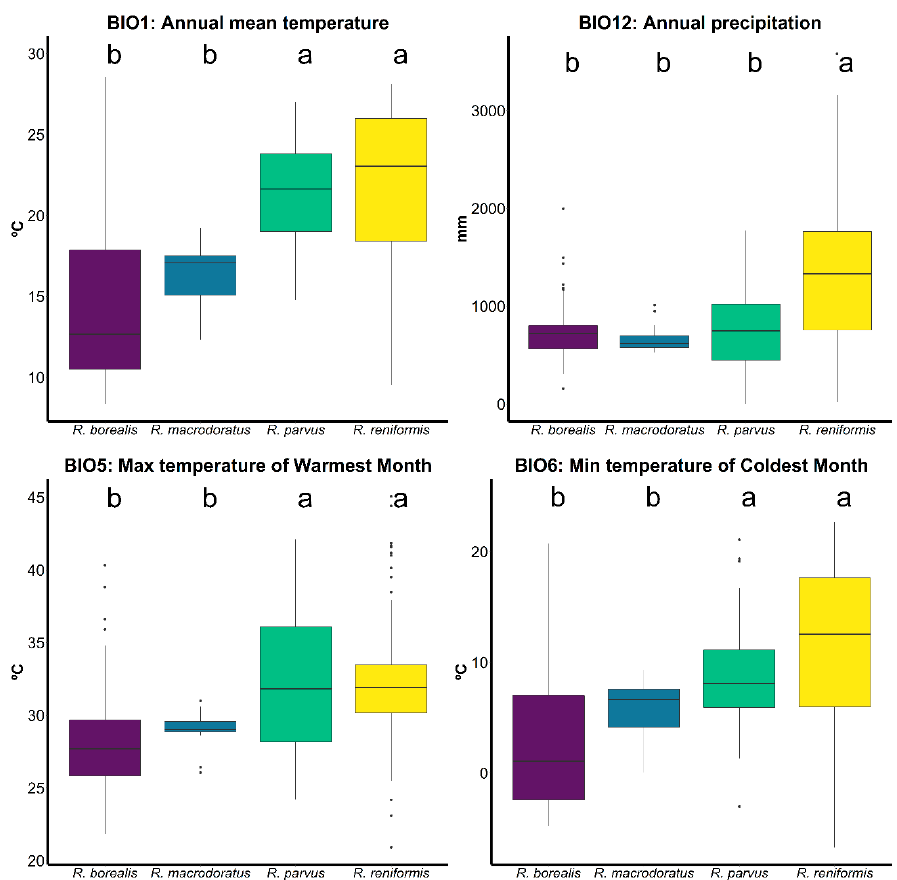
Figure 7. Annual mean temperature, annual precipitation, maximum temperature of warmest month, and minimum temperature of coldest month for Rotylenchulus species with ≥ 3 reports (each single dot correspond to a species report). The different lowercase letters indicate the differences in each bioclimatic variable between species. They were tested using ANOVA with a level of significance of p < 0.05.